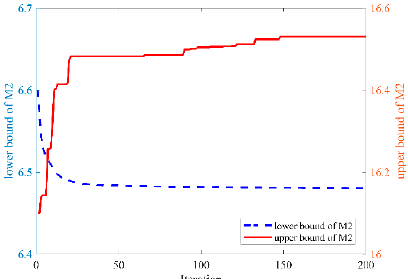
Appl. Sci. 2020 , 10 , x FOR PEER REVIEW Figure 5. Optimization iteration procedure of calculating bounds of M 2 in Case 2.